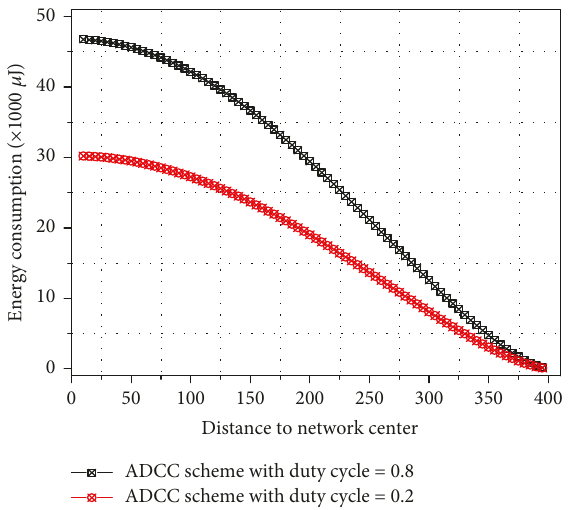
Figure 2: The energy consumption of nodes in the network with di ff erent duty cycles.